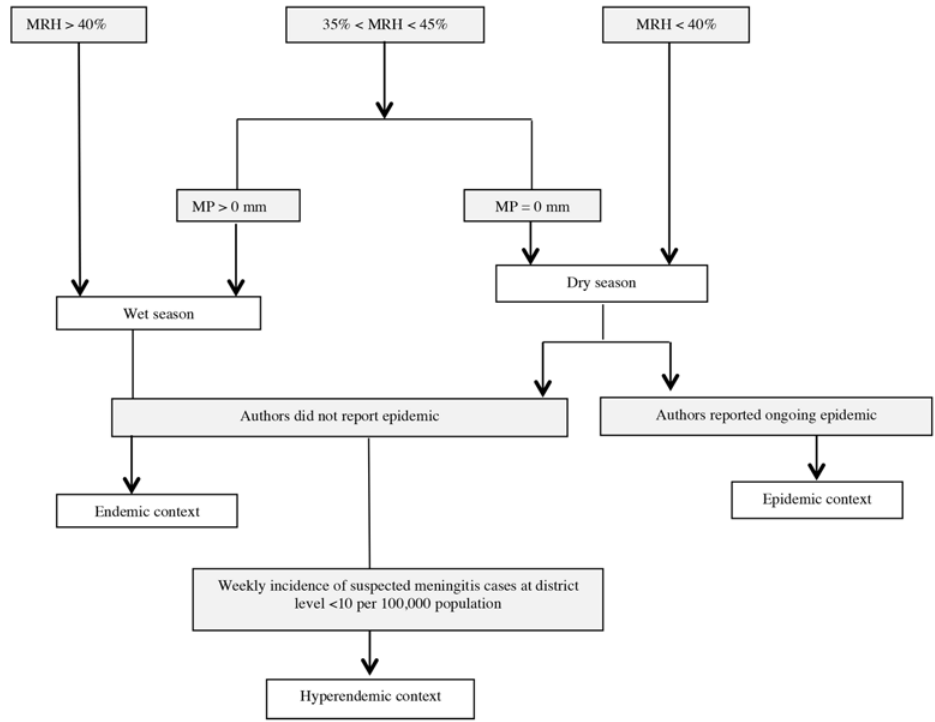
Figure 1. Algorithm for the definition of season and epidemiological context of case-carrier observation units reported by publications. MRH = Mean daily relative humidity in the two weeks preceding study onset or MRH of the study month (when only month of study was reported). MP: Mean daily precipitation amount (mm) during the two weeks preceding the study.